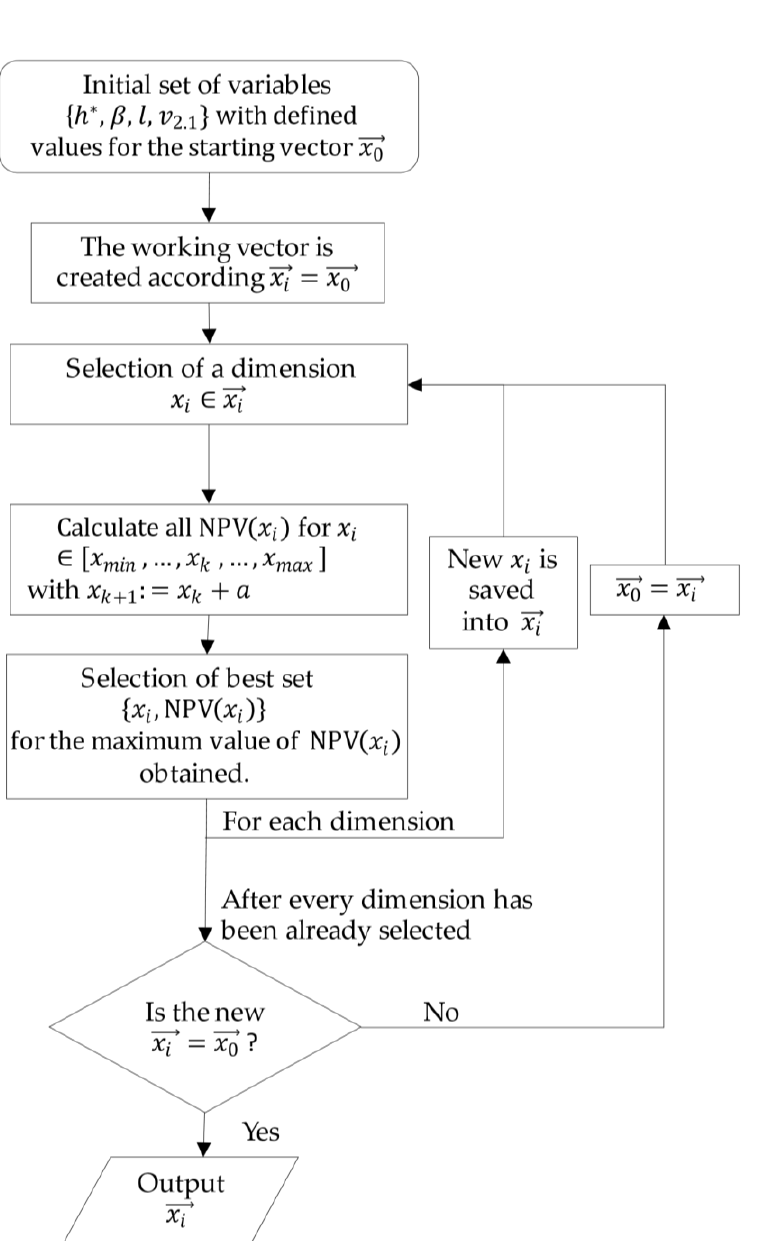
Figure 4. Optimization algorithm flow diagram.